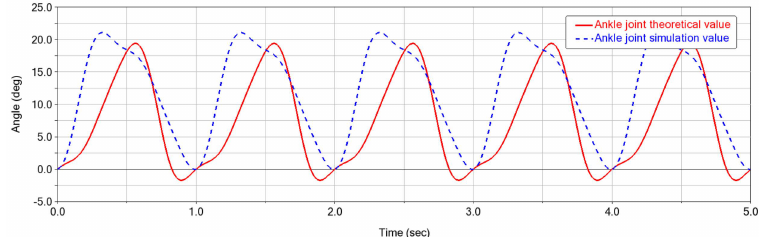
Figure 24. Ankle angle variation